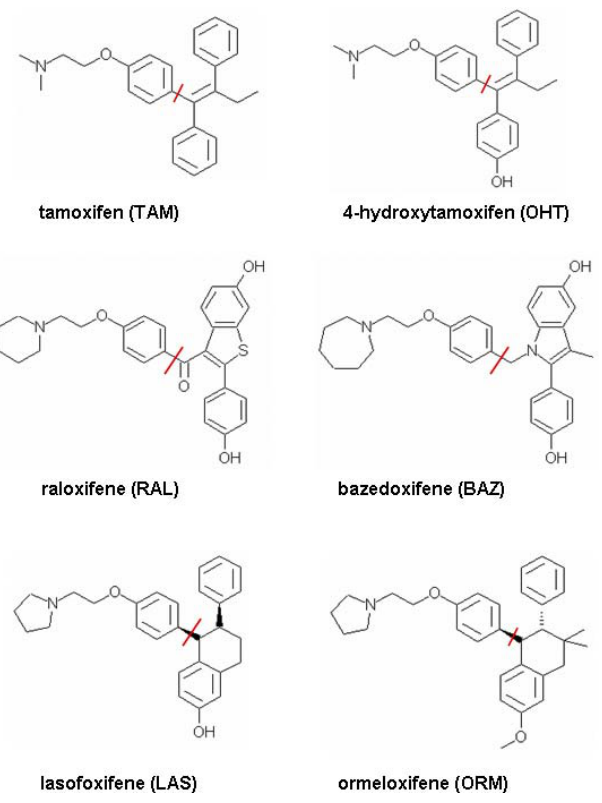
Figure 6. Six Selective Estrogen Receptor Modulators Either Commer- cially Available or in Clinical Trial N- and C-moieties are broken down by bonds marked with red bars and on the left and the right sides of 2D schema,